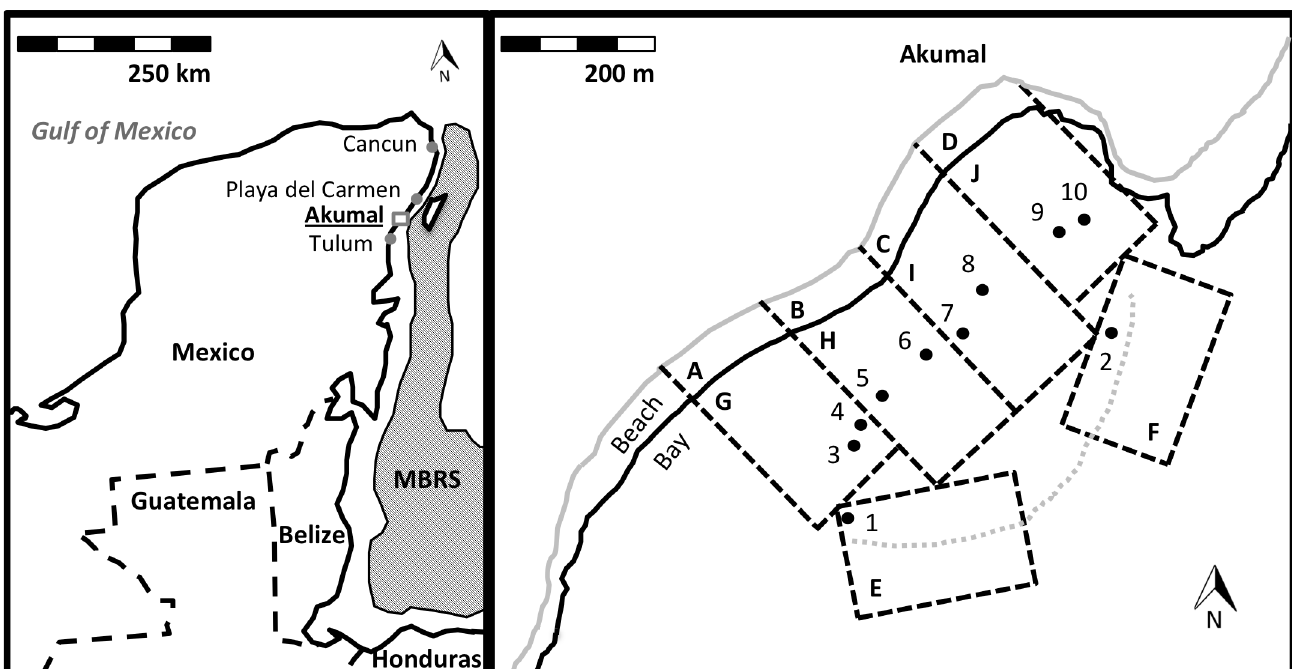
Fig 1. Maps of (a) Yucatan Peninsula showing major tourist cities, and (b) Akumal Bay showing areassampled in the present study. In (a), the extent of the Mesoamerican Barrier Reef System (MBRS) is shown as a shaded area along the coastlinesof 4 countries: Mexico, Belize, Guatemala, and Honduras. The study site at Akumal is underlinedand marked with a rectangle to indicatethe area shown in detail in (b). The detail map in (b) presents the 10 bay sections in which visitor abundances were quantified,each identifiedby letter in the upper left corner of the section (delineatedby dashed lines): 4 sectionson land along the beach, sampledfor beach visitors (A-D), and 6 in the water, sampledfor snorkeling visitors (E-J). G to J are inner bay sectionsthat parallelthe on-landsections A to D, and E and F are reef crest sections along the mouth of the outer bay. Shownalso are patch reefs #1–10 sampledfor coral reef benthiccommunity composition:2 reefs in each of the 4 inner bay sections, and 1 reef each in the 2 outer bay sections. The landwardedge of the sandy beachis delineatedby a solid grey line, the water’s edge (coastline)by a solid black line, and the coral reef crest by a dotted line. For detailsand site comparisons see text here and maps in [17,43,46].